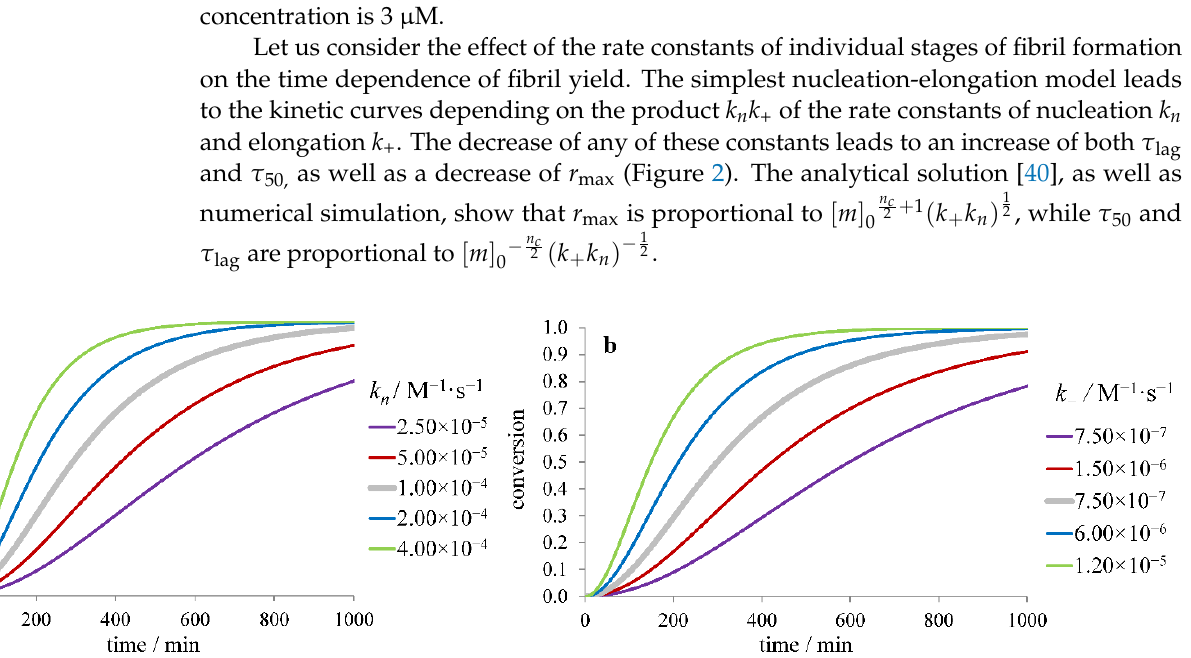
Figure 2. Dependence of the fibril formation time course on ( a ) nucleation ( k n ), ( b ) elongation ( k + ) rate constant for the model considering only nucleation and elongation.